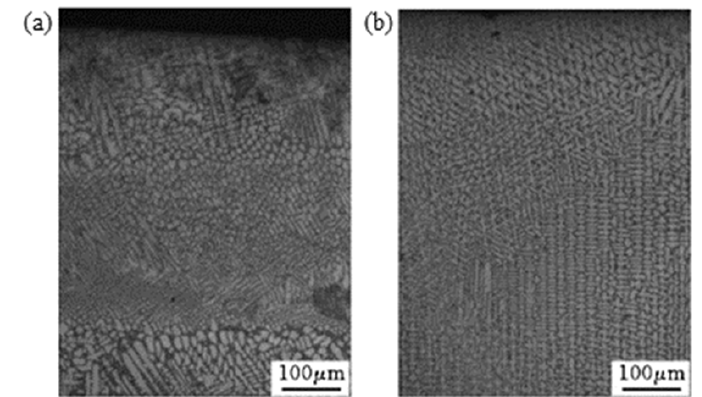
Figure 11. Effects of alternating magnetic fields on the grain size in Fe-based cladded layers fabricated by LMD (the laser power is 3 kw and the scanning speed is 350 mm/min): ( a ) without alternating magnetic fields; ( b ) with alternating magnetic fields [75].